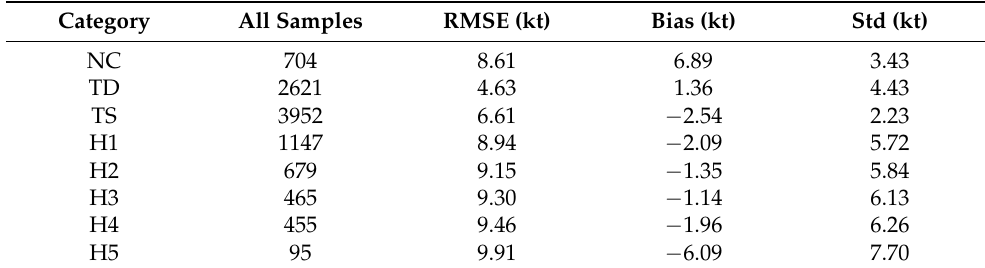
Figure 5. RMSE and Bias with different TC categories. Table 8. RMSE, Bias, and Std for different TC